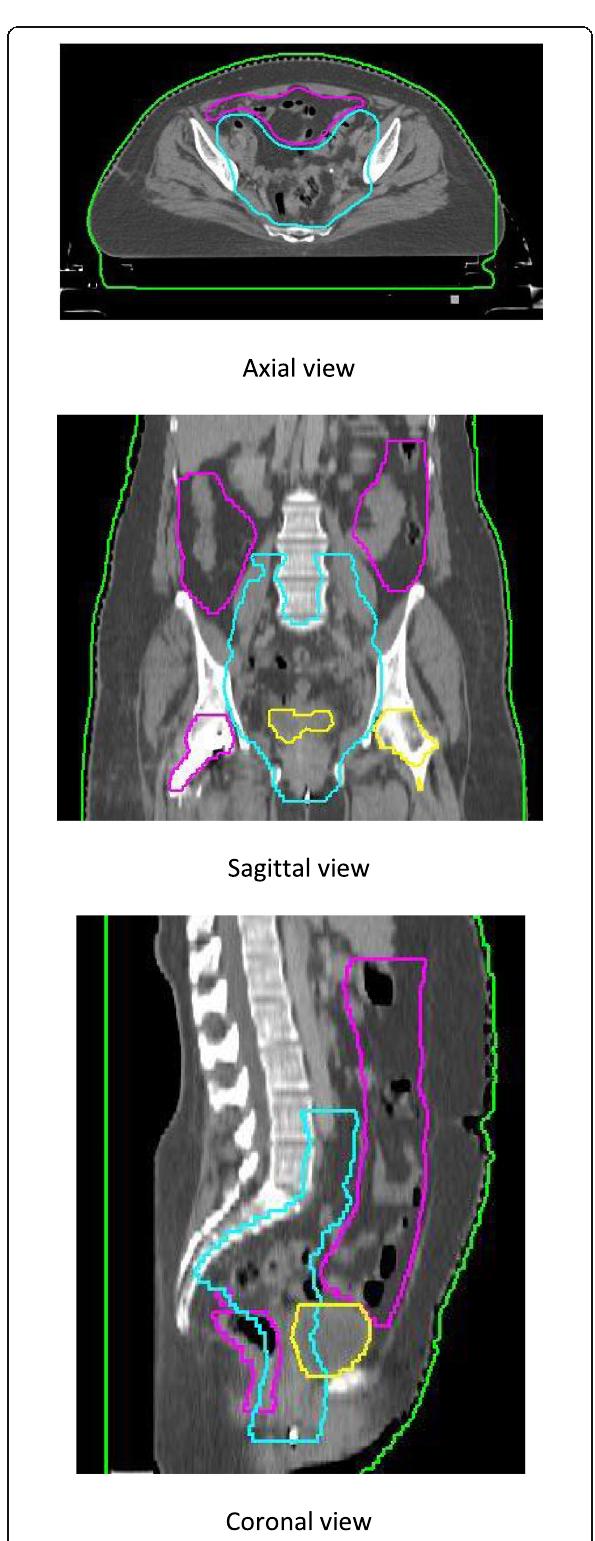
Fig. 1 Delineation of contours showing prosthesis in the right